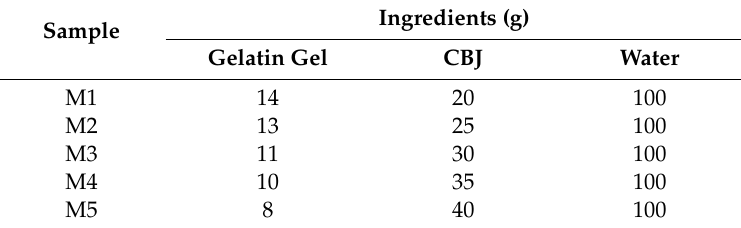
Experimental conditions for the aerated concentrated blueberry juice (CBJ)–gelatin gel